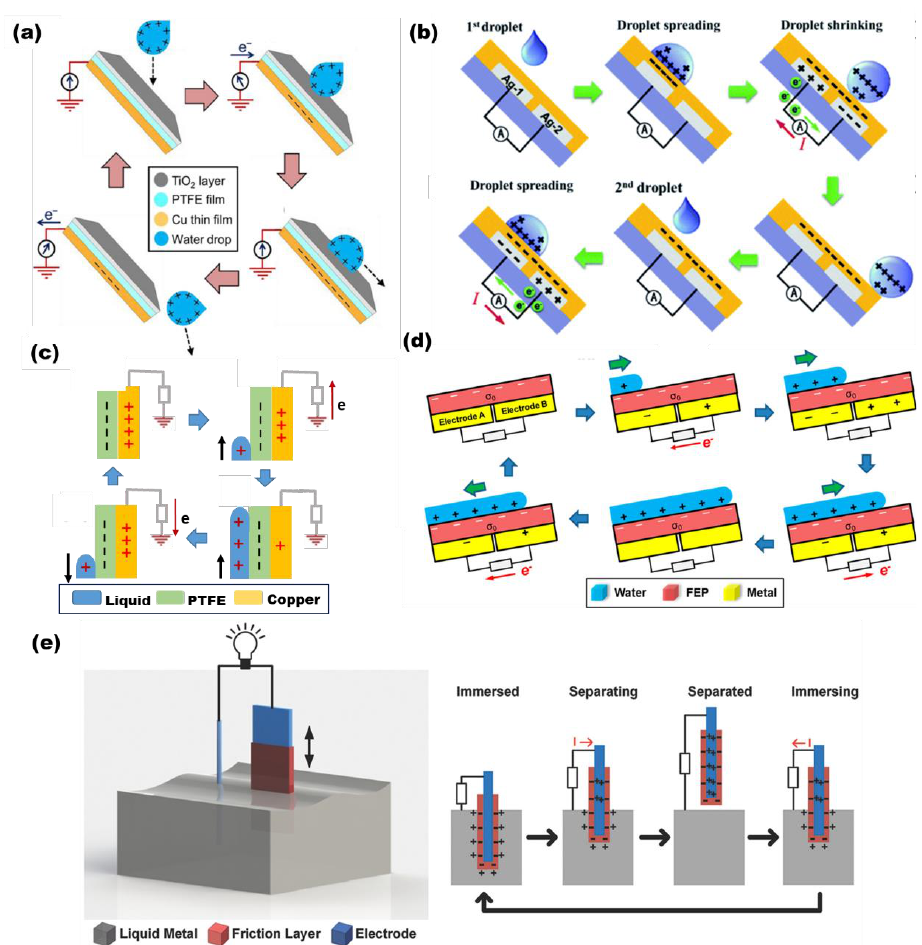
Figure 3. ( a ) Single-electrode waterdrop mode TENG (reproduced with permission from [105]